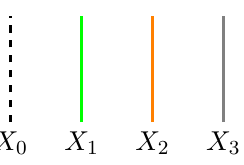
Figure 8 . The new vacuum X 0 is denoted by a dashed line, and the other three excitations are distinguished by different colors.